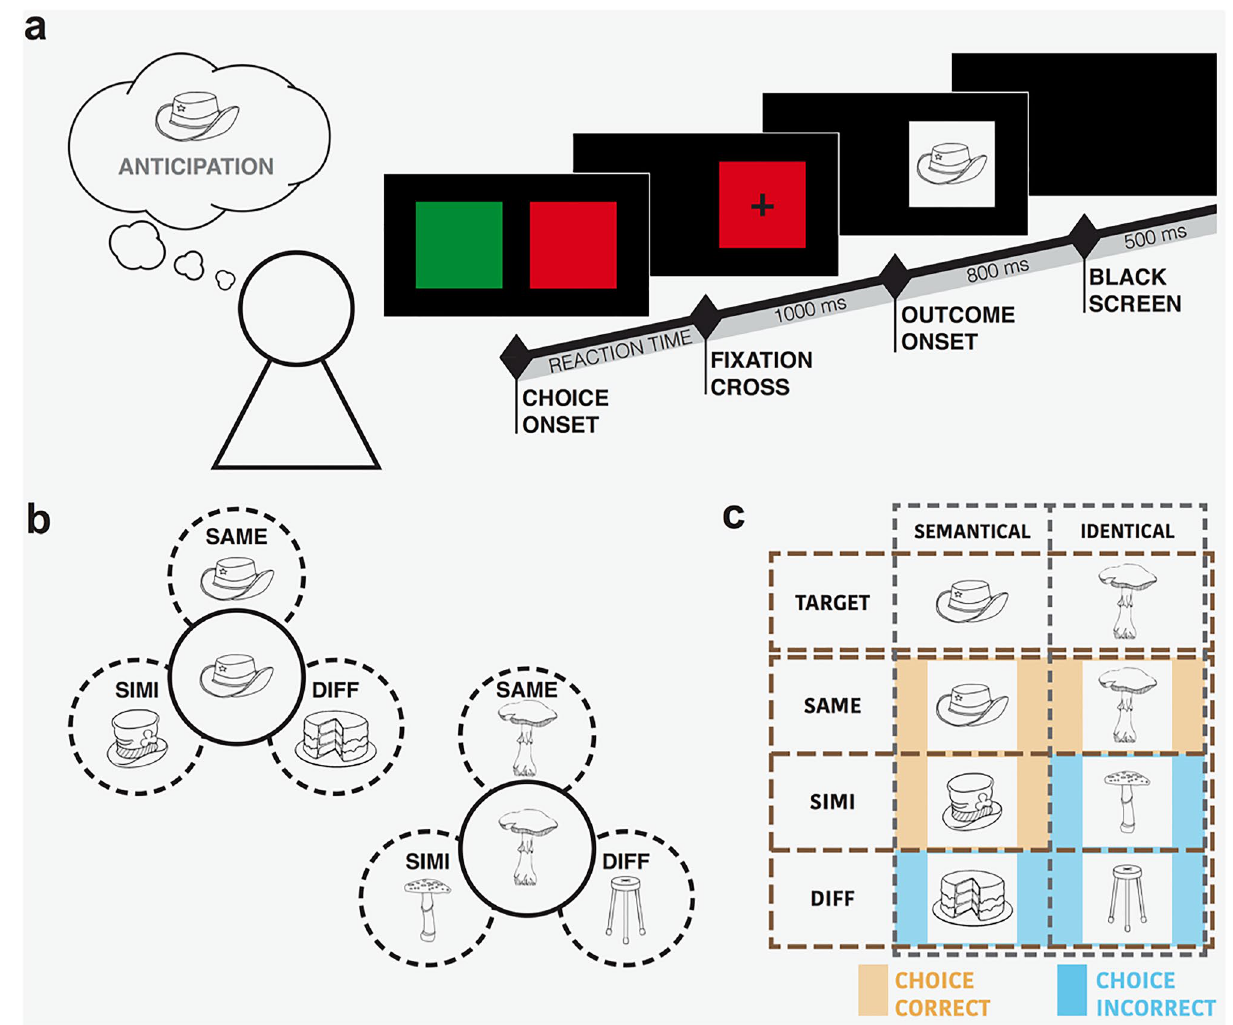
Figure 1. Task’s design. ( a ) Time line of the trial. It starts with the presentation of two colored squares (choice onset). A fixation cross appears as soon as the subject has selected a square, followed by the presentation of the outcome (outcome onset). The trial ends with a black screen. ( b ) Example of three different categories of possible outcomes. SAME represents the identical object, SIMI represents a semantically similar, but not identical object, and DIFF represents an object from another semantic group. ( c ) Categorization of the outcomes, according to the condition, the type of object and the required subsequent behavior: orange indicates stimuli after which subjects have to continue to choose the same square while a blue indicates stimuli that should induce a switch on the next